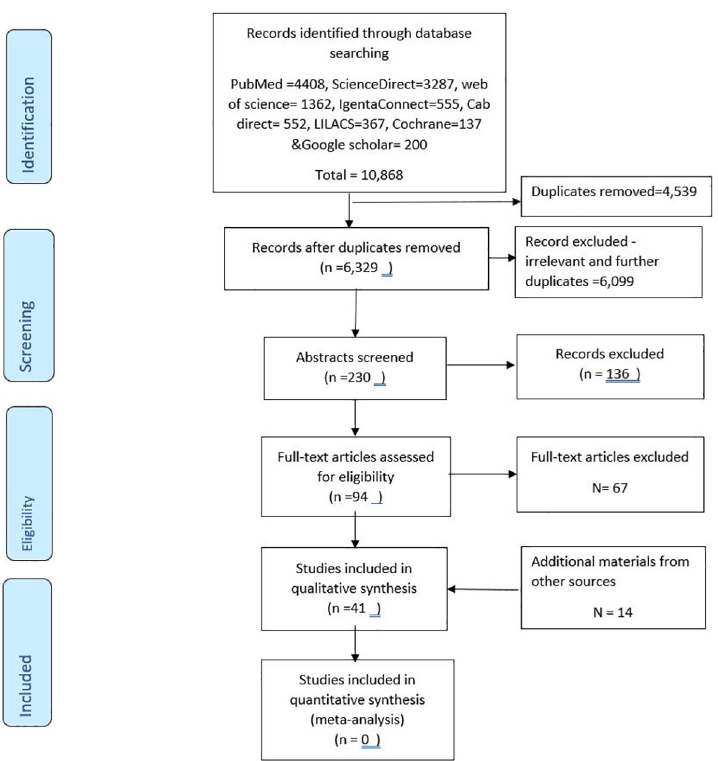
Fig 1. PRISMA flow chart of the selection process in the systematic literature review of contextual factors for T . solium